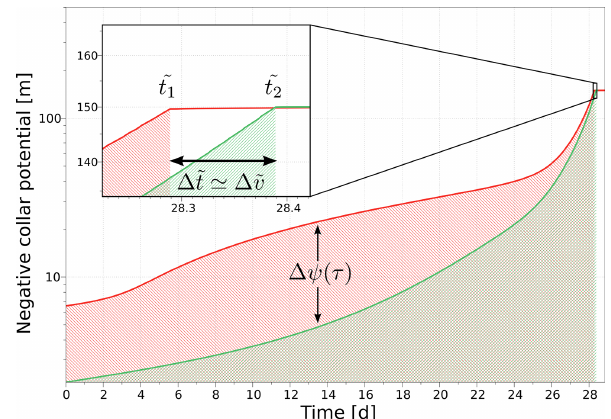
Figure 2. Evolution of collar xylem water potential over the course of time for two exemplary chosen single roots of equal total length (0.8m): an unbranched homogeneous young root (red) and a branched root with six tips (green). Water yield measures the to- tal amount of water that could be extracted before reaching critical xylem water potential. Effort is given by the area below the graph, divided by the respective occurrence times of water stress. Although water yield is very similar between the two root structures in this case, effort is substantially